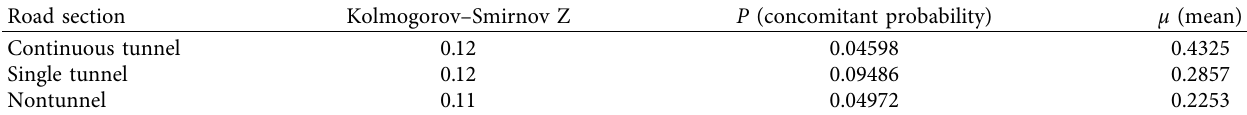
Table 2: Kolmogorov–Smirnov test results for three types of road sections.